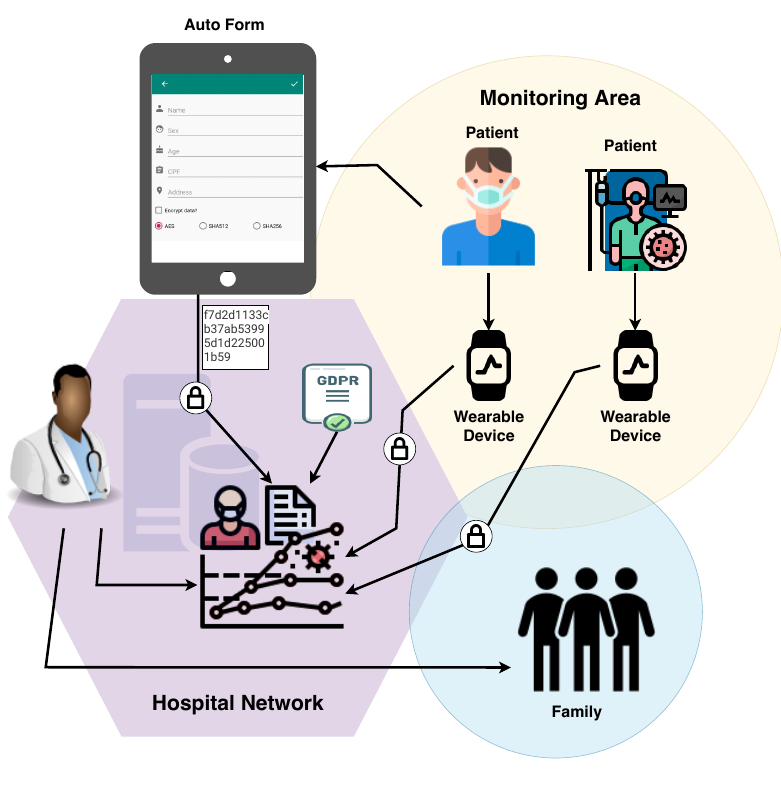
Figure 10. Application